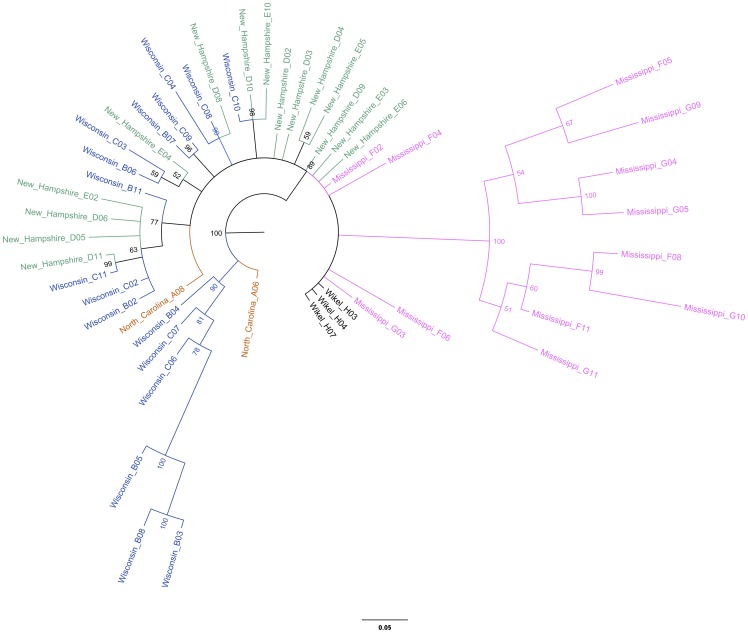

I. scapularis Bayesian phylogeny of concatenated nuclear sequences (see Figures S2, S3, and S4 for individual gene trees).Pink  =  Mississippi; blue  =  Wisconsin; orange  =  North Carolina; green  =  New Hampshire; purple  =  Pennsylvania; and black  =  Wikel Colony. Numbers at nodes represent posterior probability values and branch length corresponds to number of substitutions.